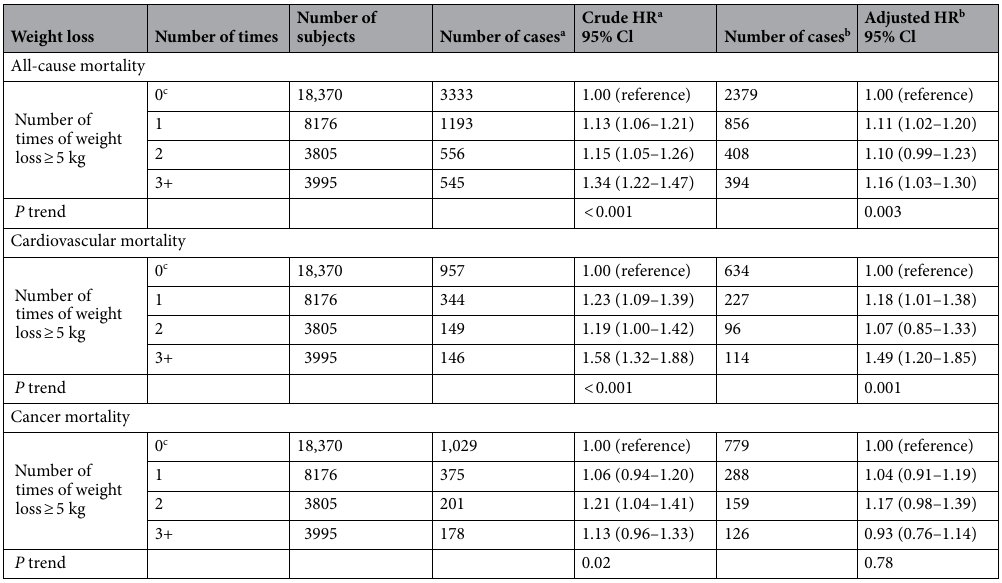
Table 4. Number of times of weight loss of ≥ 5 kg and hazard ratios of overall mortality, cardiovascular mortality, and cancer mortality. HR hazard ratio, CI confidence interval. a Adjusted for age and sex at enrollment. b Adjusted for age, sex, body mass index, cigarette smoking, alcohol consumption, level of education, income, physical activity, sleep, and subjective health. c Participants who answered “no” to the question “Have you ever lost 5 kg or more in less than a